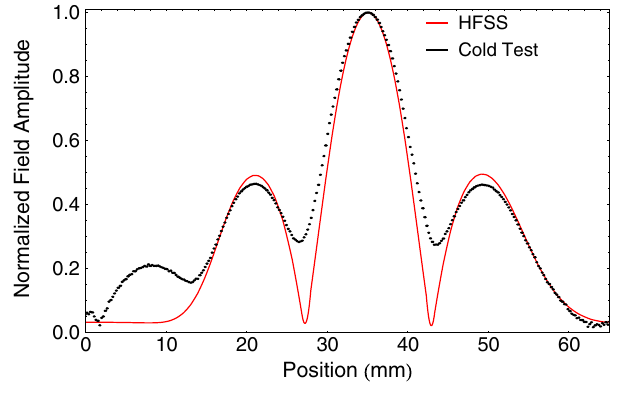
FIG. 9. (cid:4) mode field profile